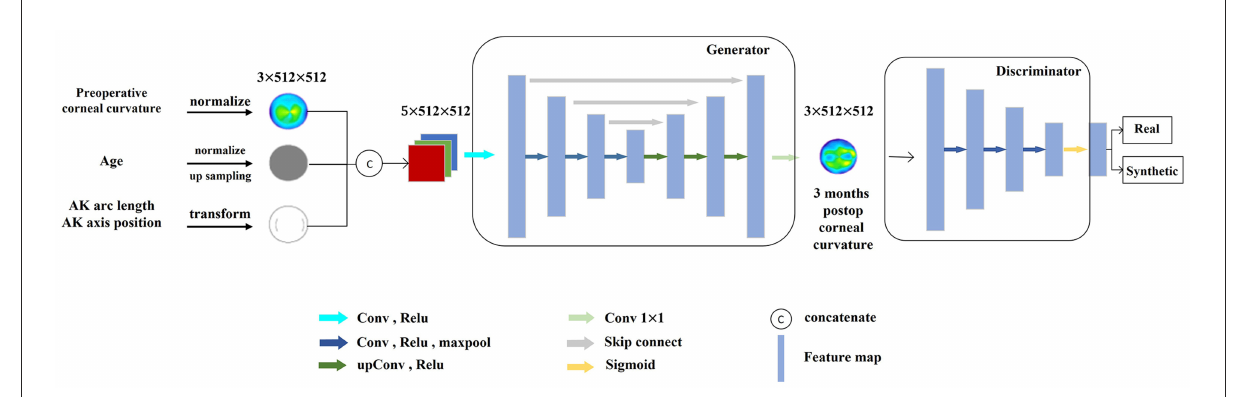
FIGURE4 Structure of the postoperative corneal tomography prediction